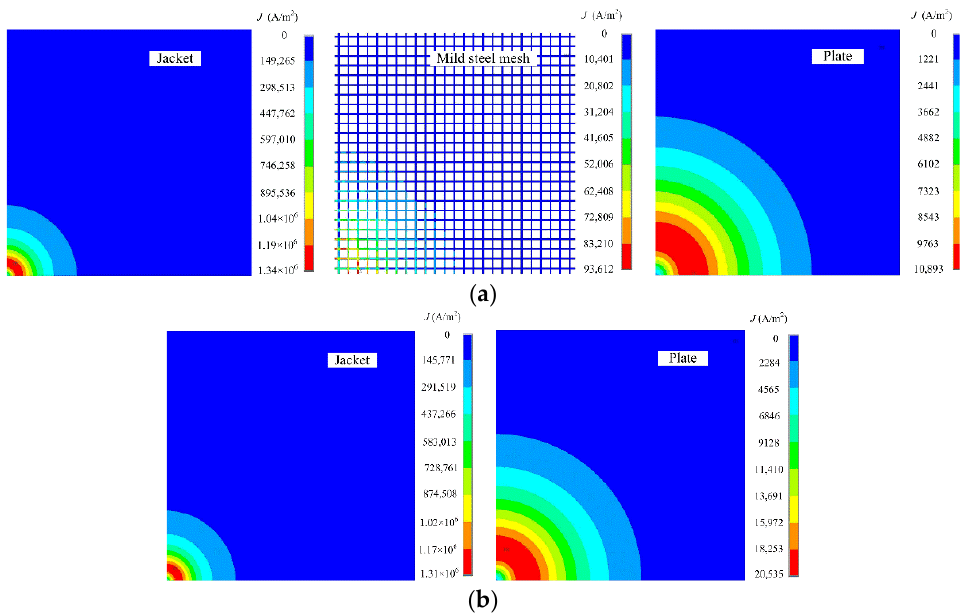
Figure 4. Contour plots of eddy current density in conductive components of the models ( a ) with a mild steel mesh, and ( b ) without any metal mesh,